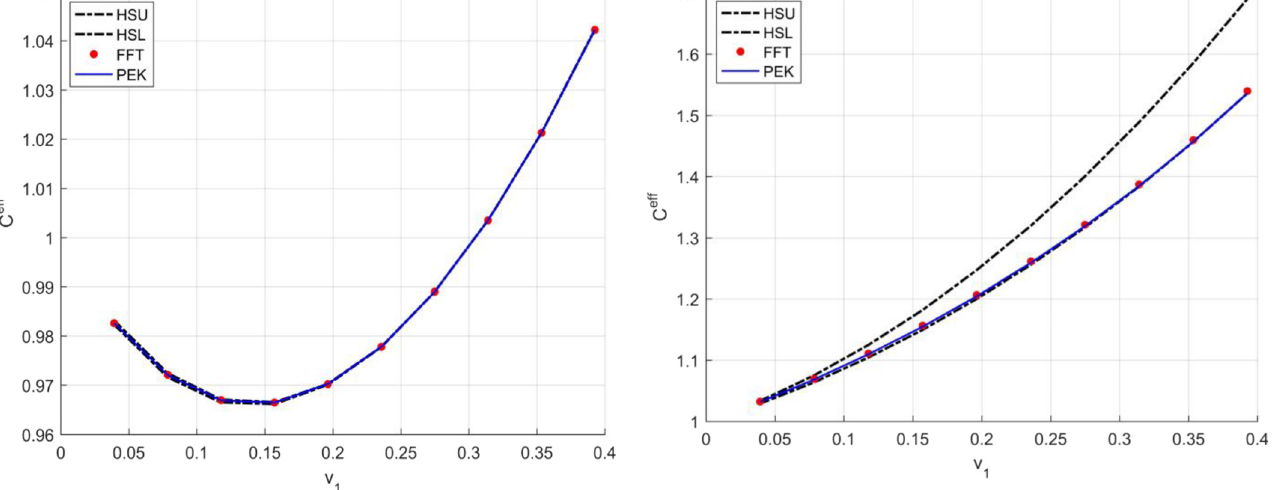
Fig. 8. Effective conductivity of square model with imperfect ¼ 10 . M